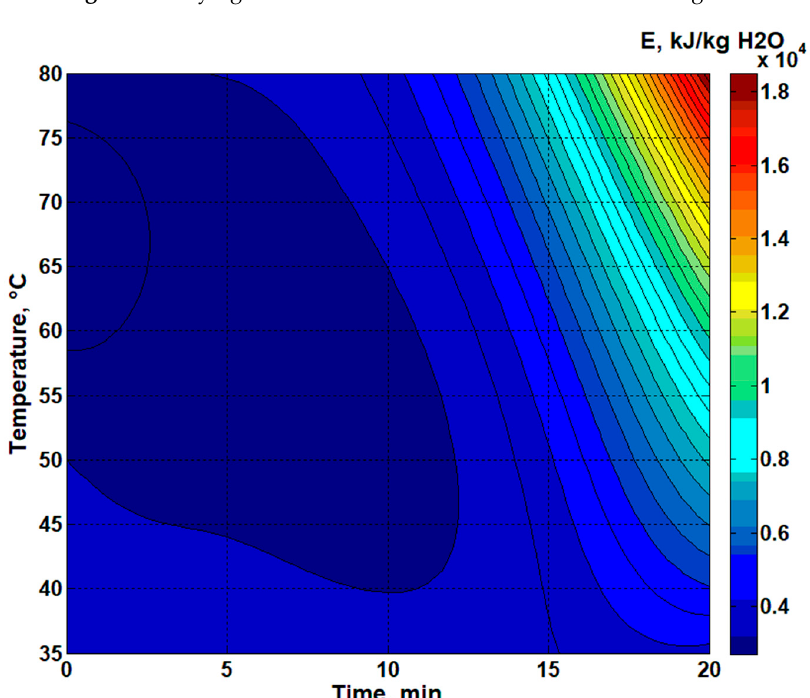
Figure 12. Total energy consumption per kg of removed water during drying of the Greek lignite in the torbed installation.